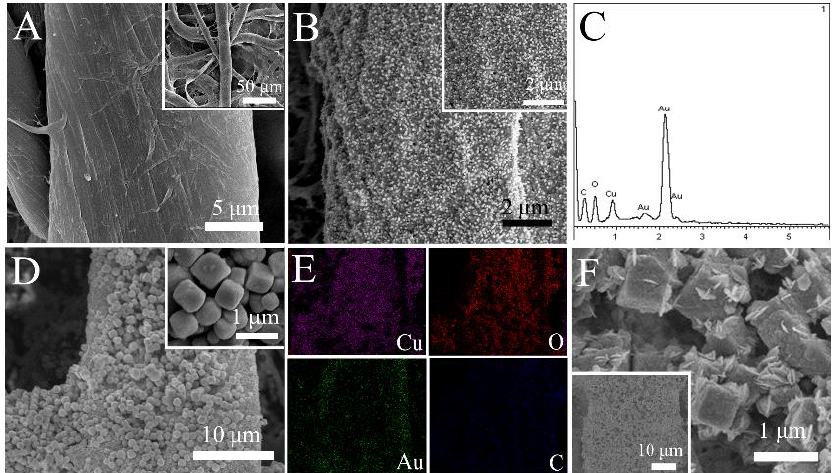
Figure 2. SEM images of ( A ) sample zone, ( B ) PWE, ( D ) PWE/Cu 2 O, and ( F ) PWE/Cu 2 O/CuO at different magnifications. ( C ) EDS and ( E ) elemental mappings of PWE/Cu 2 O.